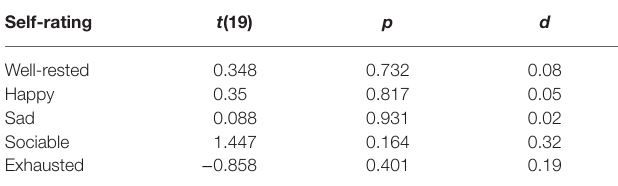
TABLE 1 | Paired t -tests including Pre-WO (baseline) self-ratings of the mood state questions in the MS and sham-MS condition, and related values of p and effect sizes